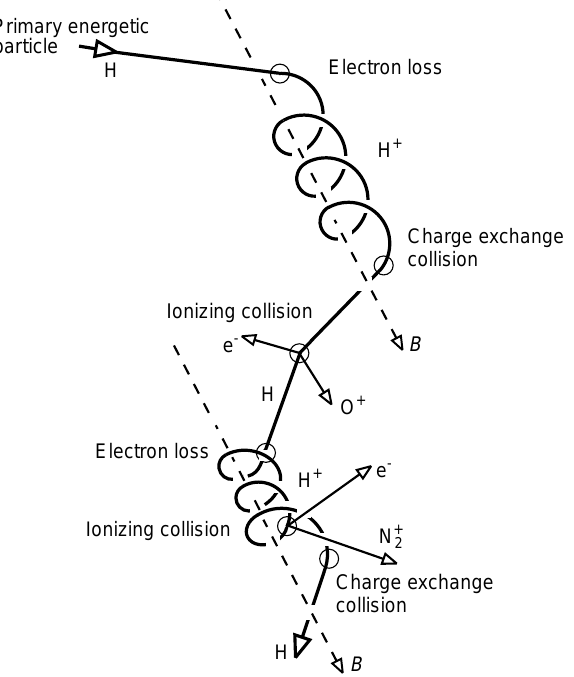
Fig. 3. Energetic hydrogen particle trajectory in the upper atmosphere. The vector B indicates the direction of the local magnetic field